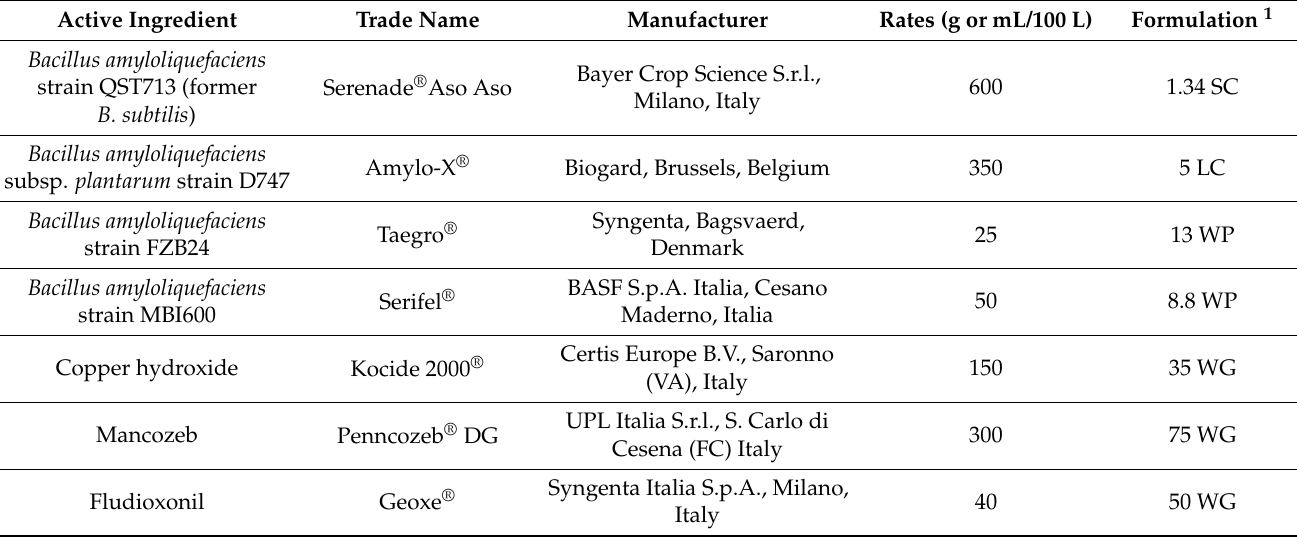
Table 7. Bioformulates and fungicides selected for in planta